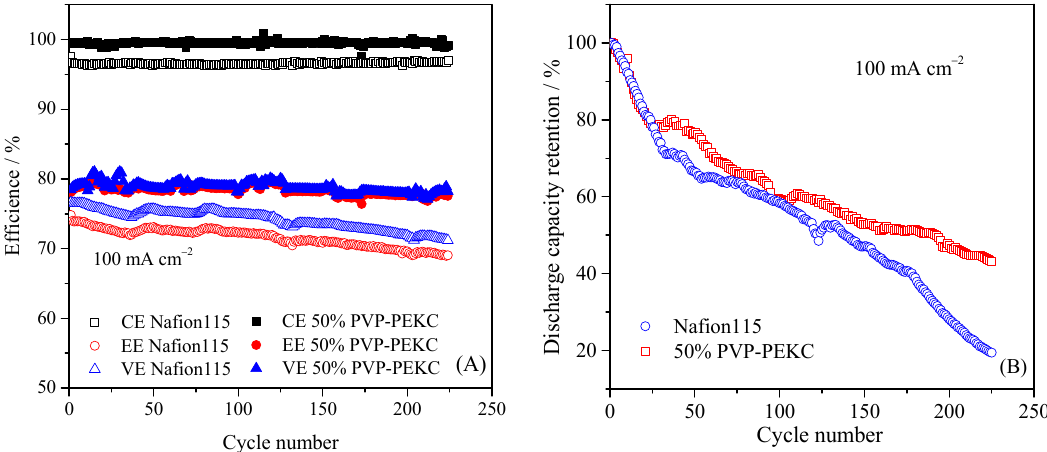
Figure 11. ( A ) Cycling performance of efficiencies of batteries with 50%PVP-PEKC and Nafion115 membranes at 100 mA cm − 2 and ( B ) discharge capacity retention at 100 mA cm − 2.